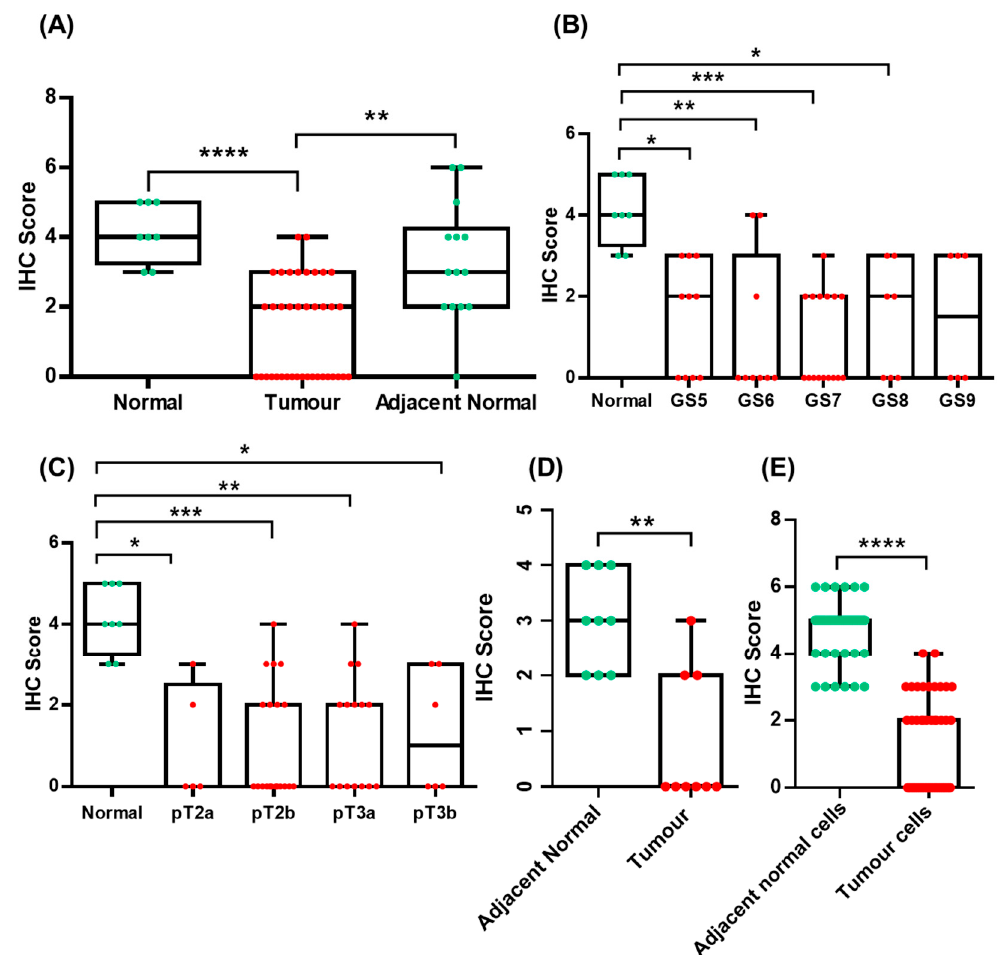
Figure 2. Gal-3 expression in normal, tumour and adjacent-normal prostate tissues ( A ), in normal and tumour prostate tissues with different GSs ( B ) and clinical stages ( C ). Gal-3 expression in tumour-matched adjacent-normal prostate and tumour prostate tissues ( D ). Gal-3 expression in co-localized adjacent-normal cells and tumour cells ( E ). (* p < 0.05; ** p < 0.01; *** p < 0.001; **** p < 0.0001).